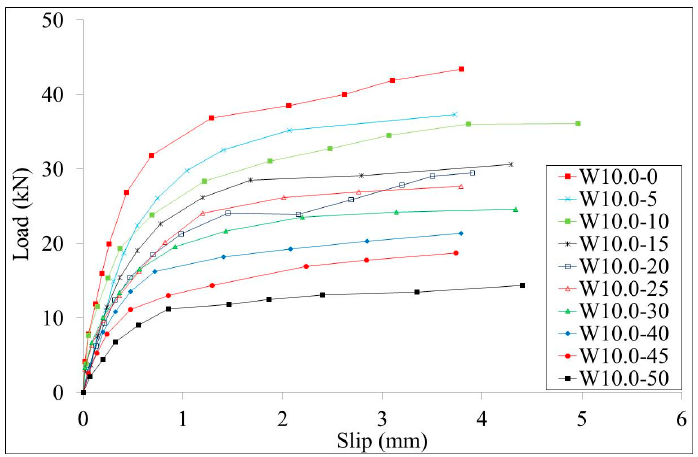
Figure 7. Load-slip curves of the W10.0 series specimens.